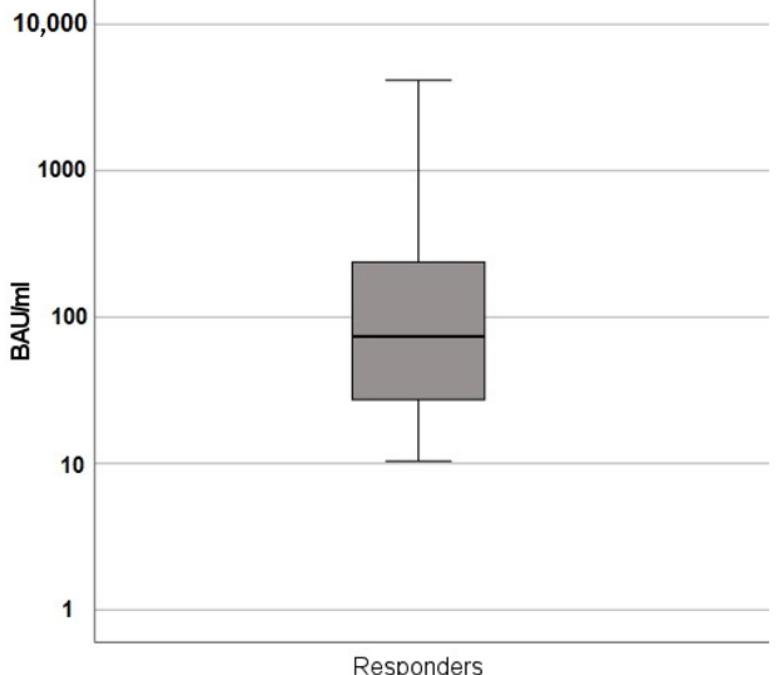
Figure 1. SARS-CoV-2 IgG titers in the seroconversion group (BAU/mL). Logarithmic scale.